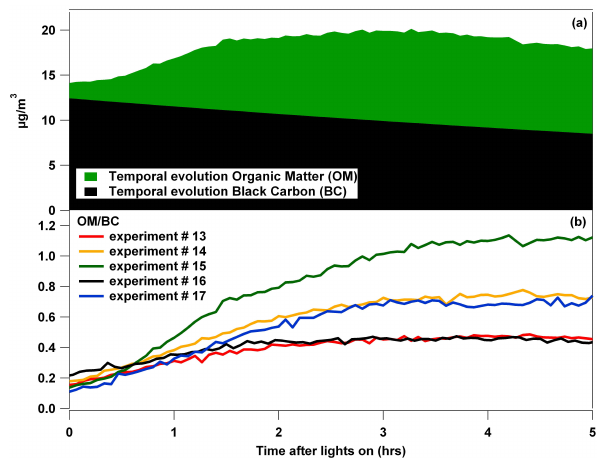
Fig. 2. (a) Temporal evolution of the organic matter (OM) and black carbon (BC) from a characteristic smog chamber experiment with substantial SOA production (exp. #15, a) and, (b) temporal evo- lution of OM/BC ratios from experiments with the diesel vehicles without